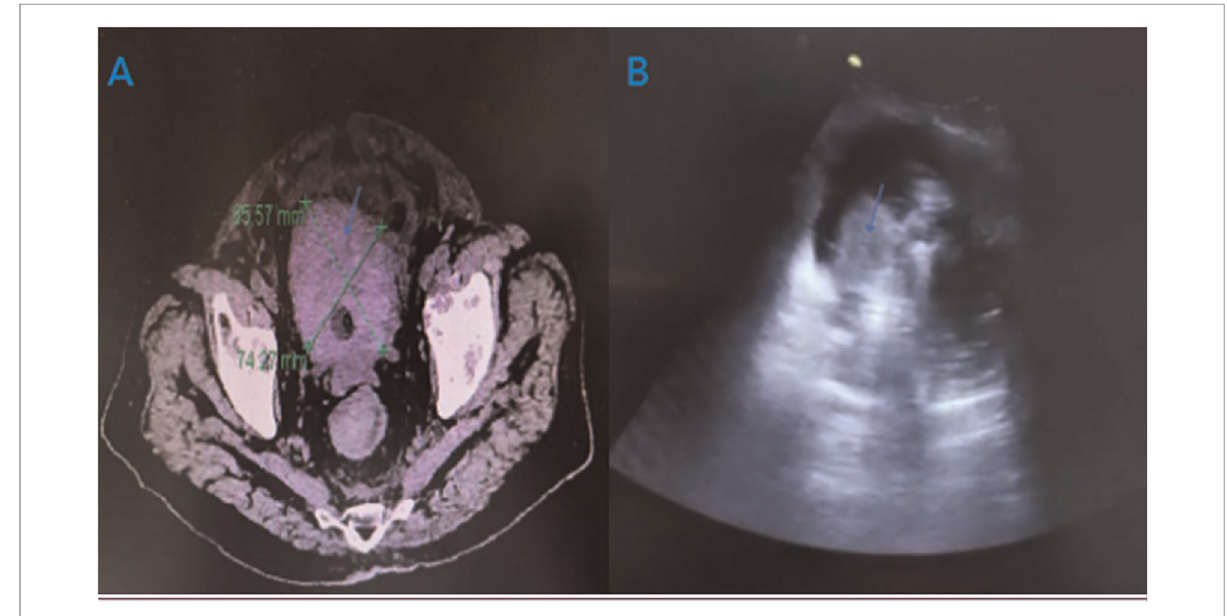
FIGURE 1 Imaging manifestations of large blood clot in bladder under CT scanning and ultrasound [( A ): CT, ( B ) ultrasound; blue arrow: blood